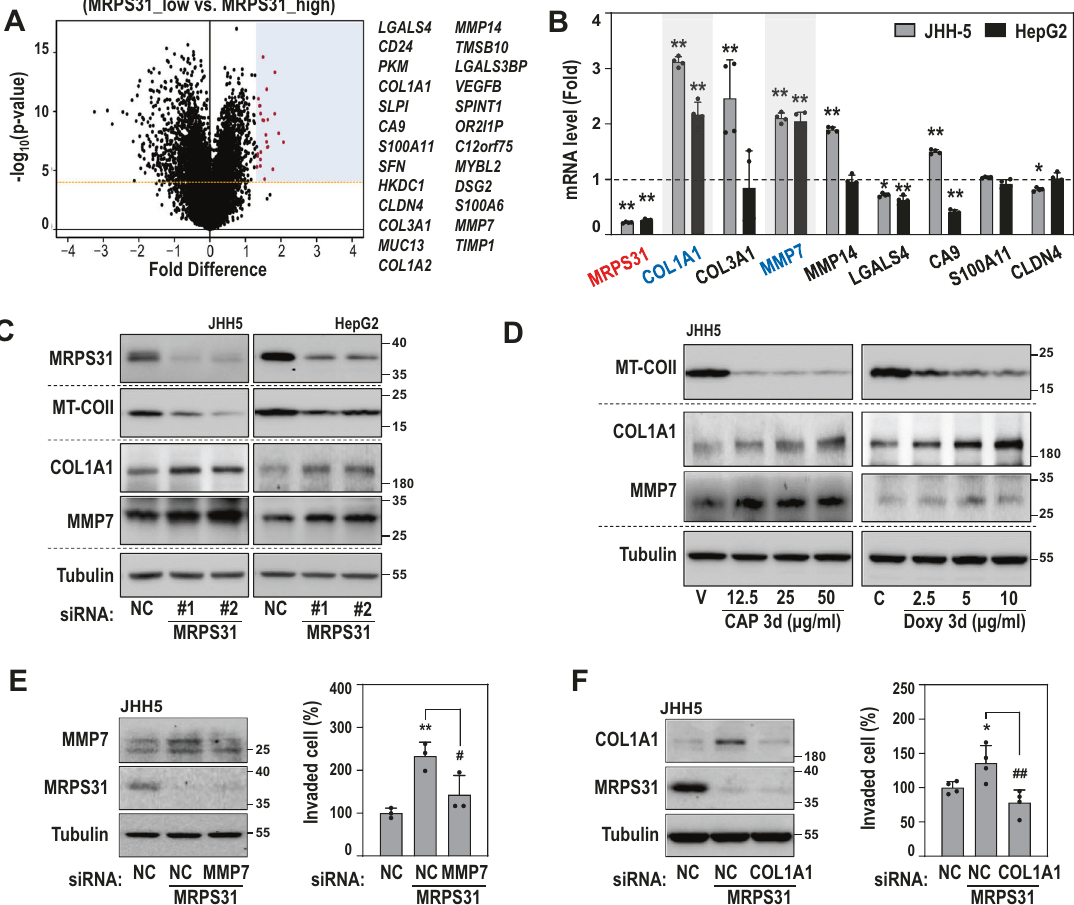
Fig. 6 MMP7 and COL1A1 are downstream effectors of MRPS31 loss to enhance hepatoma cell invasiveness. A Volcano plot of total transcripts ( n = 58,387) in TCGA-LIHC, using fold difference and p values of the expression level, based on the permutated student t test between the MRPS31_high ( n = 93) or _low ( n = 93) group. Names of highly upregulated genes (fold difference > 1.5 and permutated p < 10 − 4 , blue region) are listed (right). B, C MRPS31_high type cells (JHH4 and HepG2) were transfected with MRPS31 siRNA for 3 days. B Messenger RNA levels by qRT-PCR. Fold changes against siNC are displayed ( N = 4). * p < 0.05 and ** p < 0.01 vs. siNC by student t test. C Western blots. D Western blots of JHH5 cell exposed to the mitochondrial translation inhibitors, chloramphenicol (CAP) and doxycycline (Doxy), for 3 days. E, F JHH5 cells were transfected with MRPS31 siRNA in the absence or presence of siMMP7 ( N = 3) (E) or siCOL1A1 ( N = 4) (F) for 3 days. Western blots (left) and cell invasiveness (right). * p < 0.05 and ** p < 0.01 vs. siNC; # p < 0.05, and ## p < 0.01 vs.